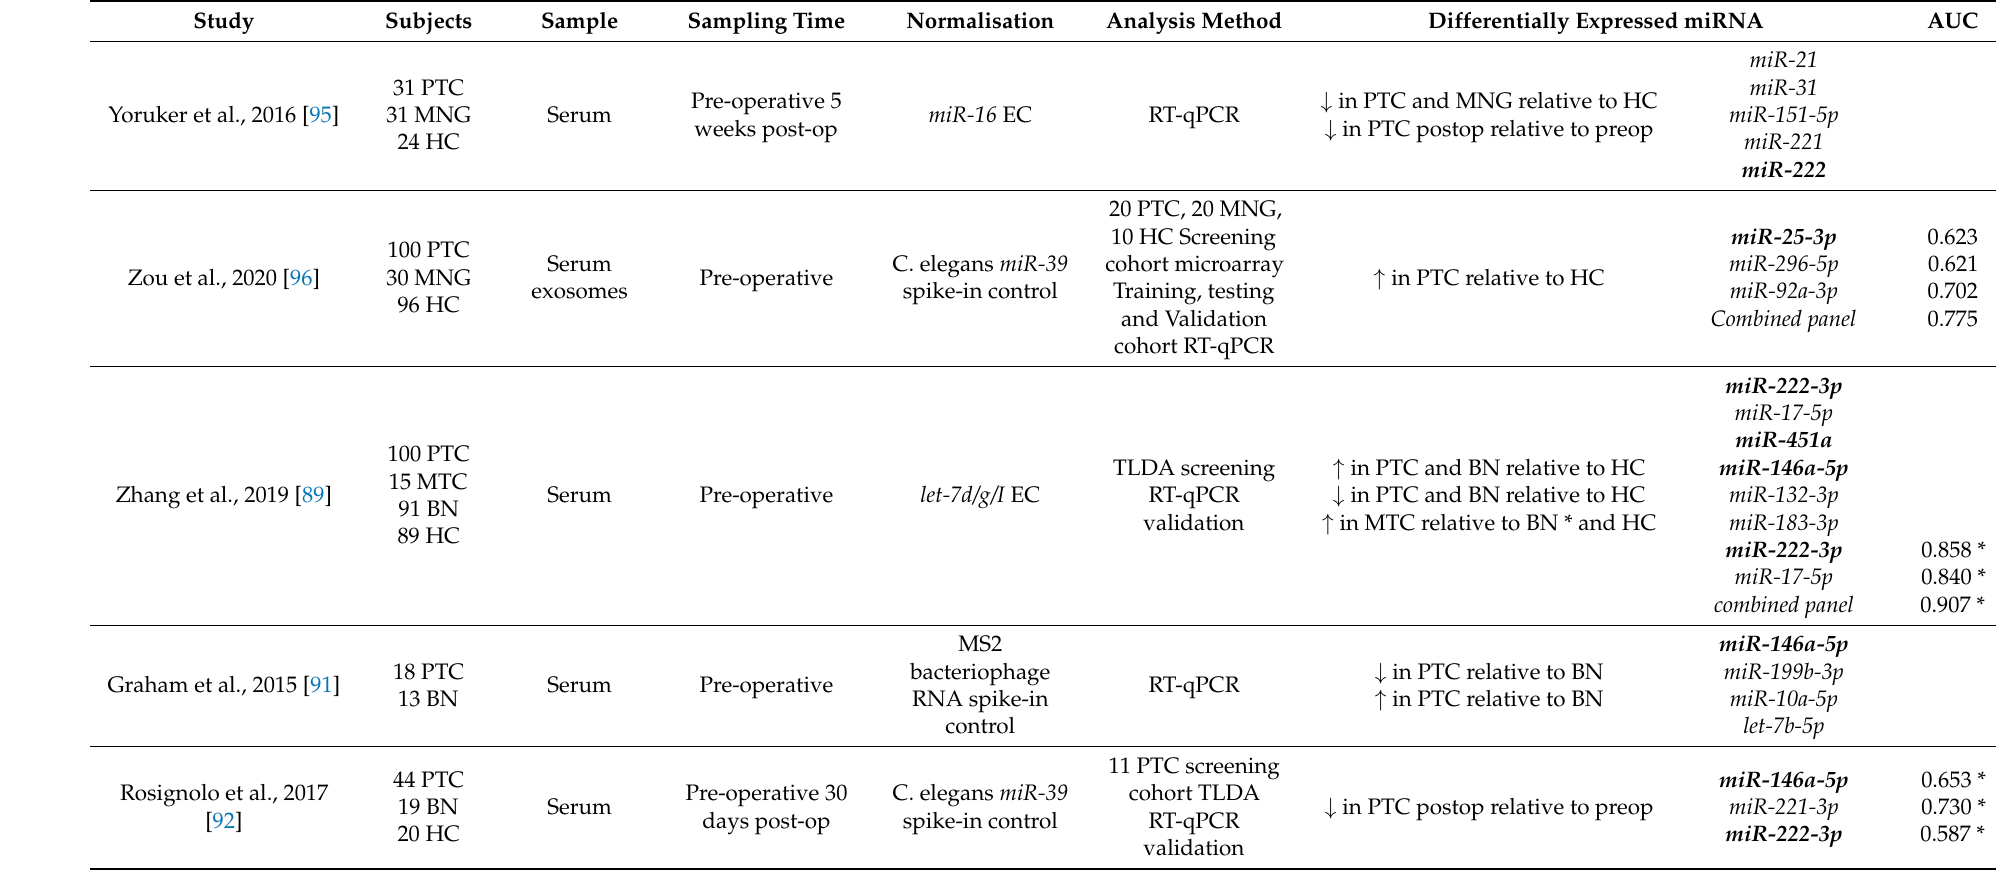
Table 2. Circulating miRNA biomarkers for the diagnosis and surveillance of thyroid